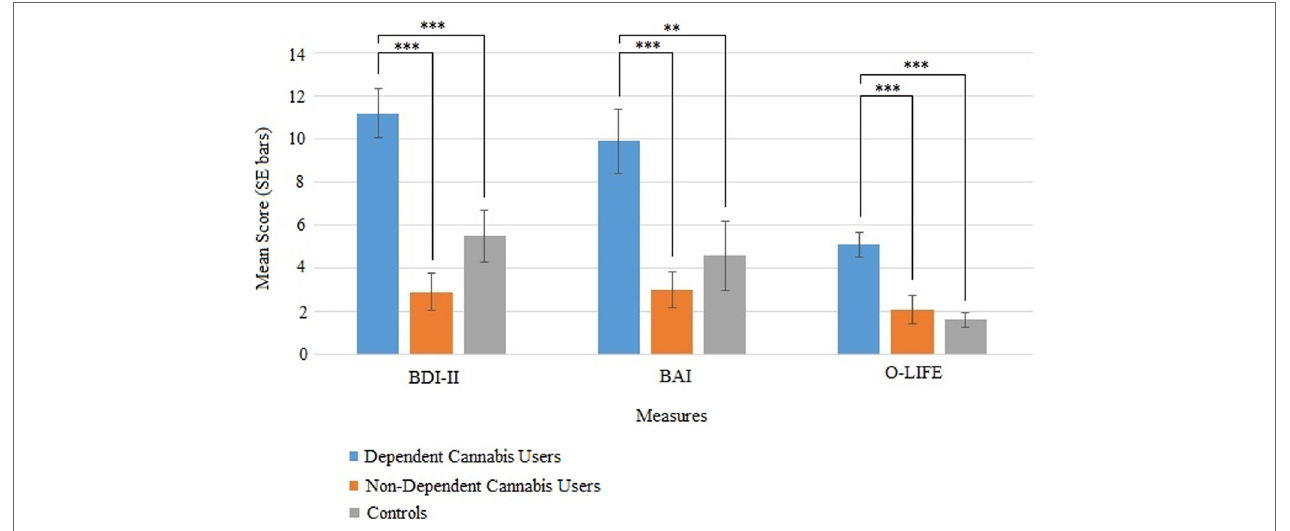
FigUre 3 | Mean (SE) scores for the BDI-II (depression), BAI (anxiety), and O-life unusual experiences (schizotypy) in the dependent cannabis, non-dependent cannabis, and control groups.